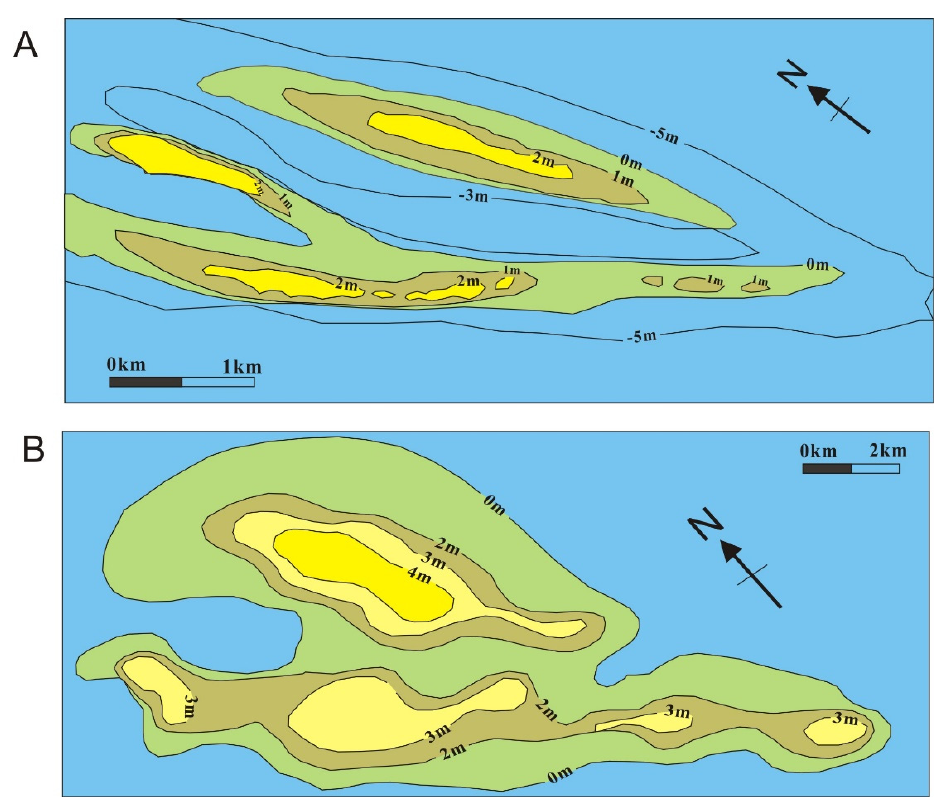
Figure 9. Spatial distribution of lobate tidal bars in McMurray Formation and Gironde Estuary: ( A ) bathymetry of lobate tidal bar in Gironde Estuary, France (modified from Billy et al., 2012); ( B ) Isopach map of Sand bar complex unit 6, McMurray Formation).